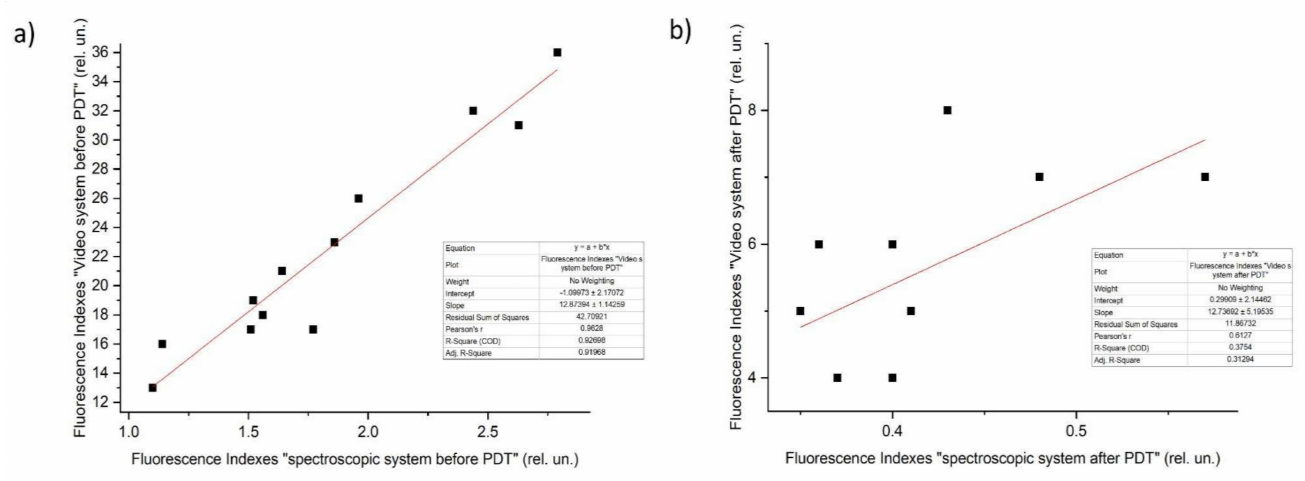
Figure 4. Regression line for two types of the obtained data: ( a ) before PDT with the video system vs. before PDT with the spectroscopic system; ( b ) after PDT with the video system vs. after PDT with the spectroscopic